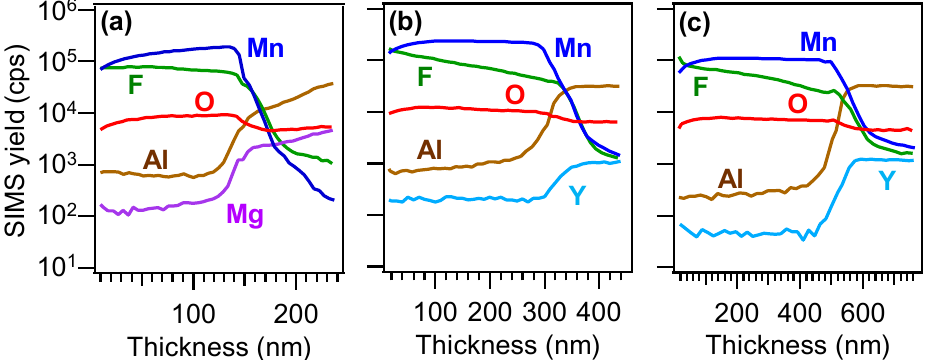
Figure 2. SIMS depth profiles for the specimens deposited on MgAl 2 O 4 (100) ( a ), YAlO 3 (010) ( b ), and Y 3 Al 5 O 12 (100) ( c ).